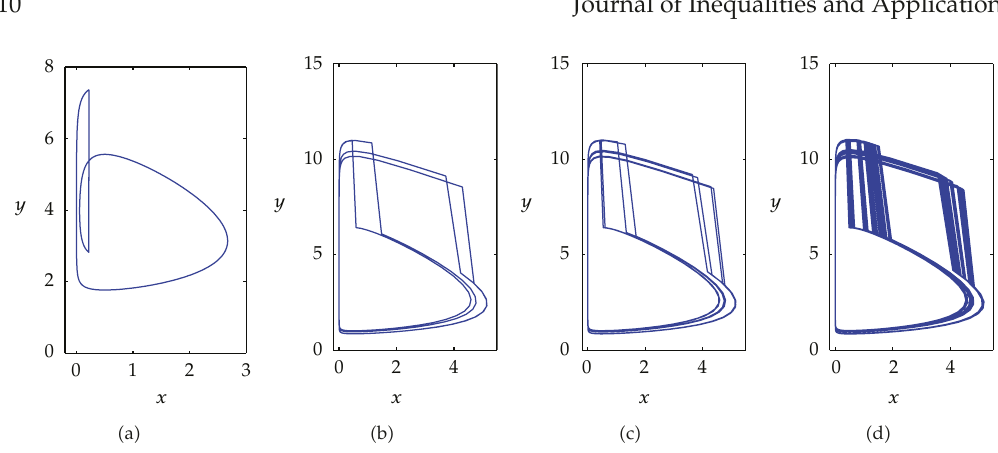
Figure 6: Phase portrait of (cid:3) 1.3 (cid:4) . (cid:3) a (cid:4) q (cid:6) 4 . 54. (cid:3) b (cid:4) q (cid:6) 4 . 57. (cid:3) c (cid:4) q (cid:6) 4 . 58. (cid:3) d (cid:4) q (cid:6) 4 . 595.